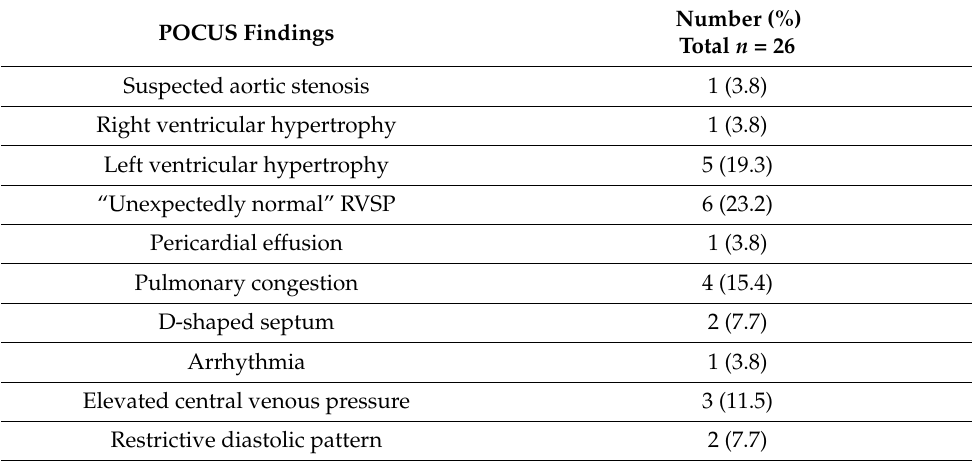
Table 4. POCUS findings.